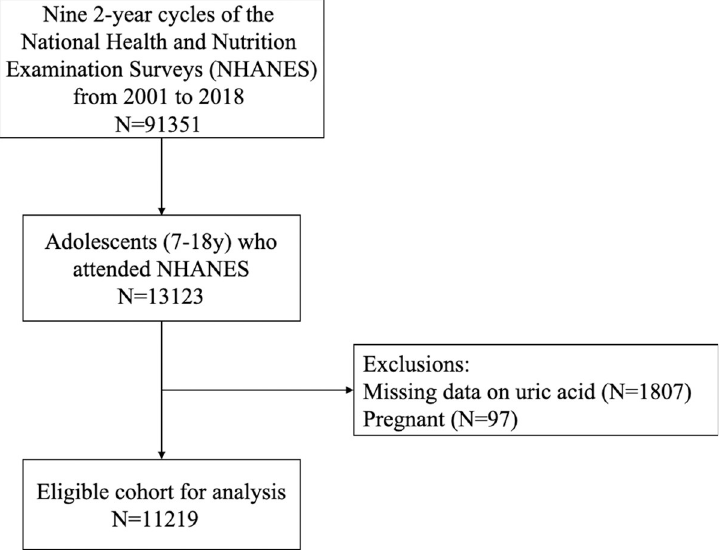
Fig 1. Eligible population and those included in the analyses of the relationship between serum uric acid and CVD risk factors in US adolescents.